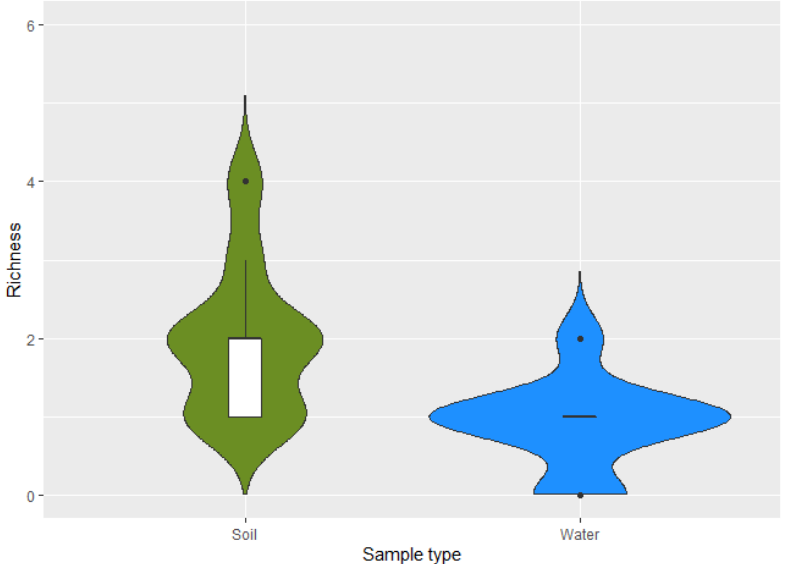
Figure 3. Bacterial richness according to sample type. Median richness (black horizontal bars); violin plots include the values within the min-max range; the width of the violin is proportional to kernel probability density of the data at different values.